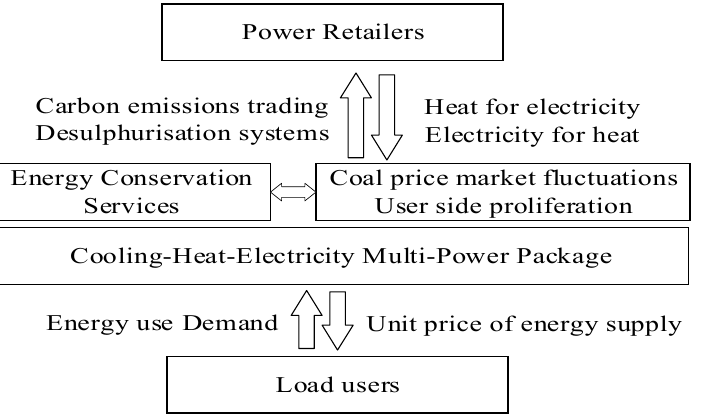
Figure 1. Schematic diagram of a cold-heat-electricity multi-energy package considering energy conservation services.